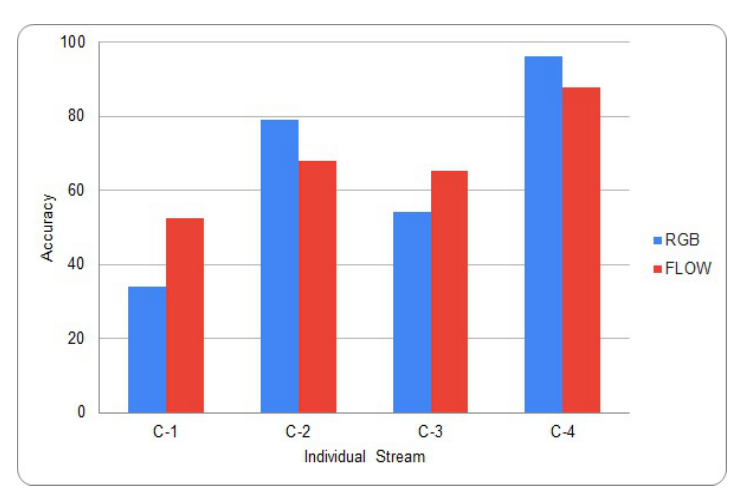
Figure 5. Inference result on UCF-101 and